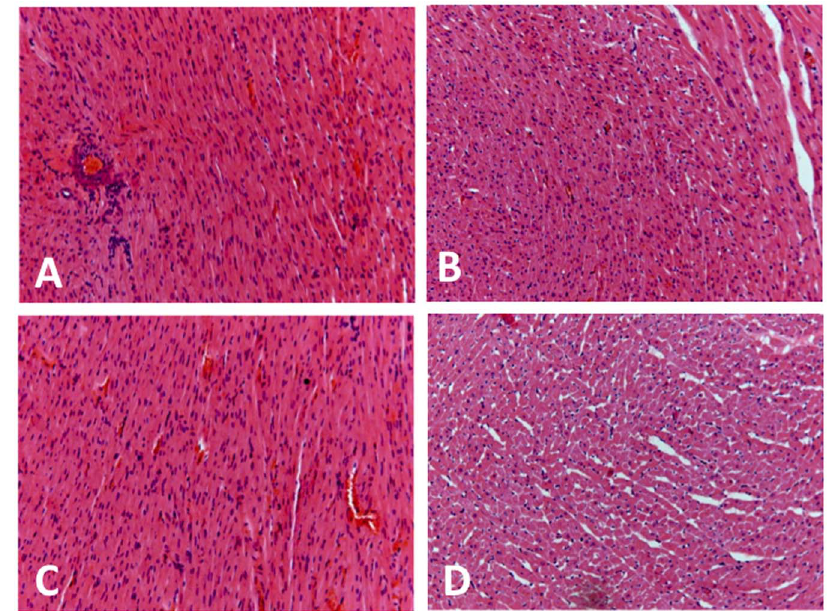
Figure 5. Representative H&E-stained histological sections (magnification of x200) of left ventricle from rats subjected to treatment for 10 consecutive days with testosterone and cocaine alone and in combination. ( a ) control group (vehicle + saline) showing normal cardiac muscle fibers; ( b ) testosterone + saline group and ( c ) vehicle + cocaine group showing more spaced fibers; and ( d ) testosterone + cocaine group showing similar alterations to those observed after single treatment with the substances, but changes were more pronounced.